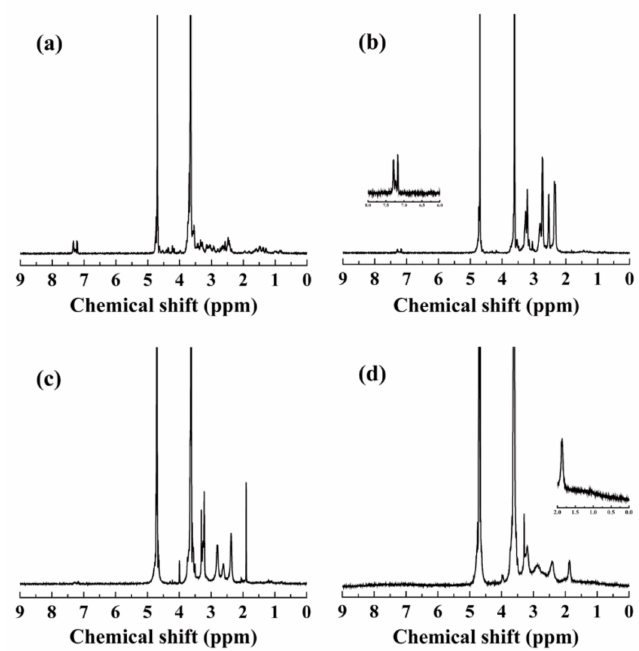
Figure 2. ( a ) 1 H NMR spectra of RGD-PEG-NHS; ( b ) 1 H NMR spectra of G5.NH 2 -PEG-RGD dendrimers; ( c ) 1 H NMR spectra of Ac-PR dendrimers; and ( d ) 1 H NMR spectra of Ac-PR/IR820 dendrimers.